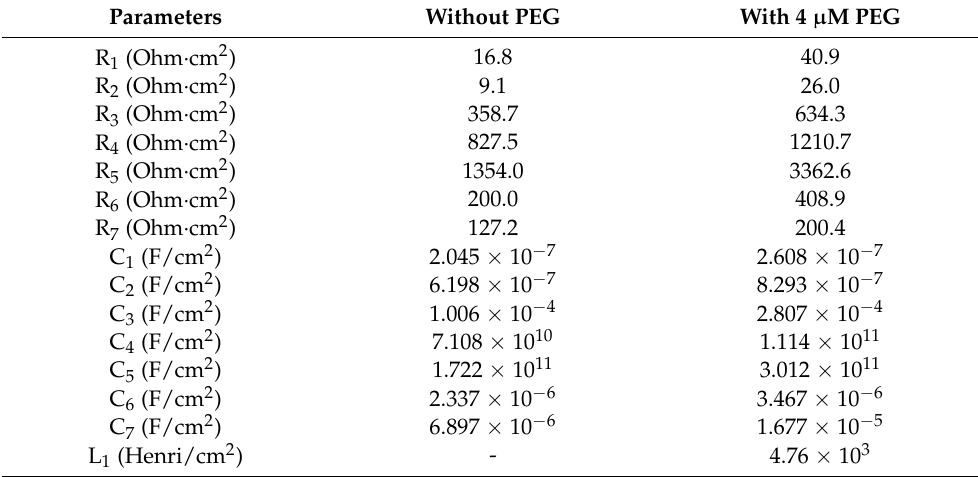
Table 2. Related parameters in Figure